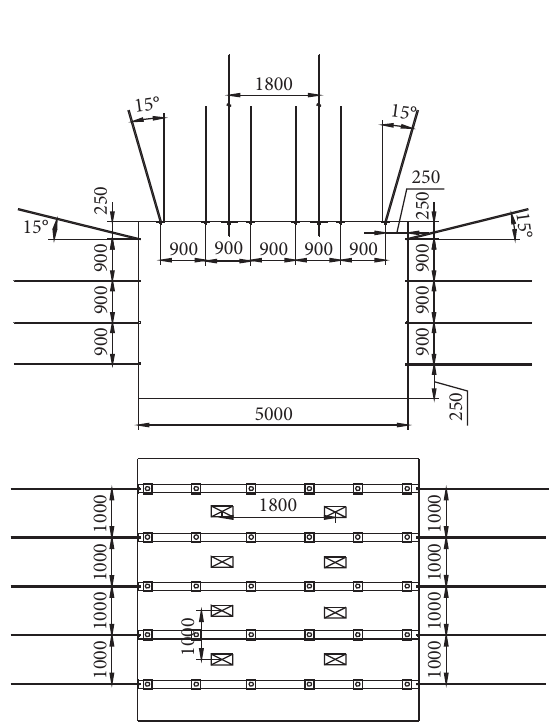
Figure 9: New support parameter of tailgate